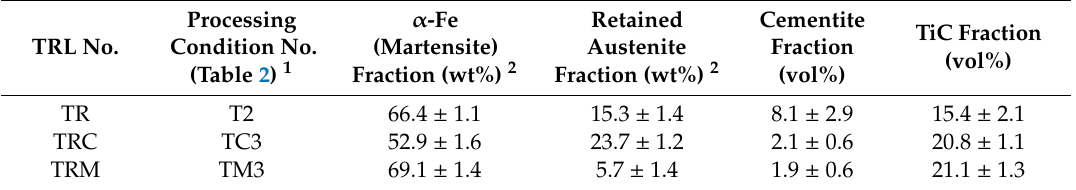
Table 4. Chemical compositions of the SALs. Element